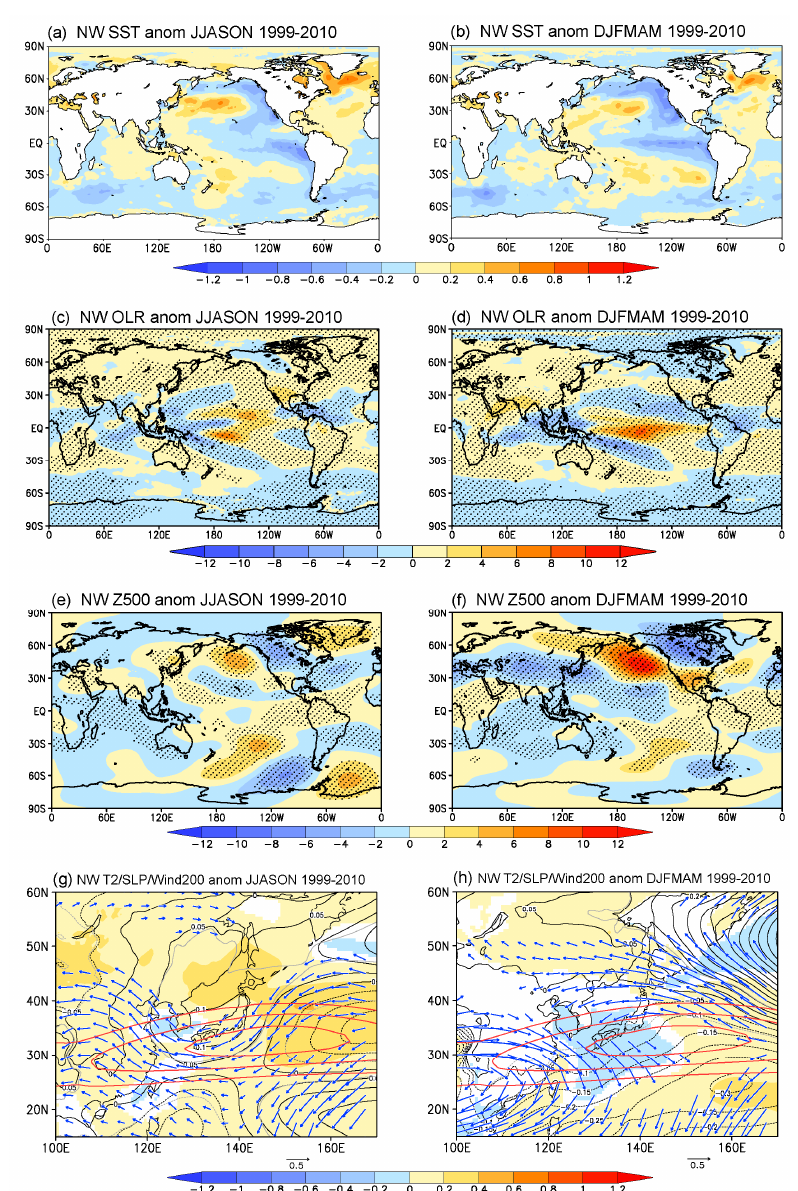
Figure 7. One hundred-member ensemble-mean anomalies of the NW run averaged from 1999 to 2010 for JJASON (left) and DJFMAM (right). ( a , b ) OLR (W/m 2 ), ( c , d ) Z500 (m, zonal mean is removed), ( e , f ) surface air temperature (shading, K), SLP (contours, hPa), and 200 hPa wind velocity (arrows, m/s). Red contours in ( e , f ) show 50, 60, and 70 m/s of climatological westerly as a reference of a mean position of the Asian Jet. In ( c – f ), dotted areas show values exceeding the 99% confidence level. In ( g , h ), red contours show 50, 60, and 70 m/s of climatological westerly as a reference of a mean position of the Asian Jet, and gray contours show the 99% confidence level of SLP. Values exceeding the 99% confidence level are shown for surface air temperature and 200 hPa wind anomalies.